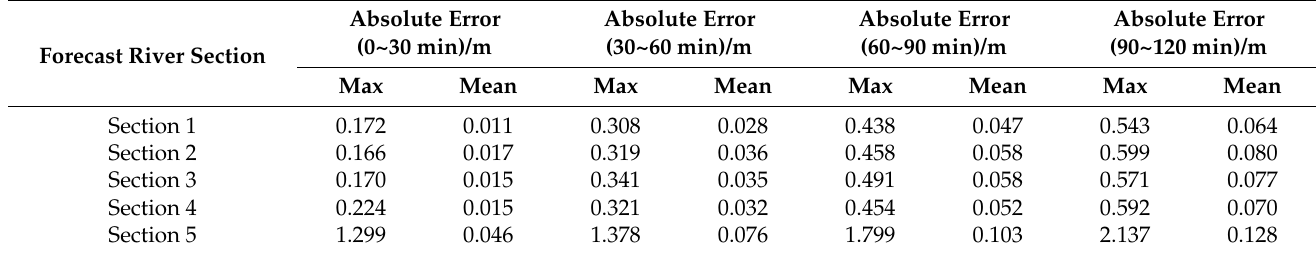
Table 2. Statistics of absolute error of water levels in different forecast times.